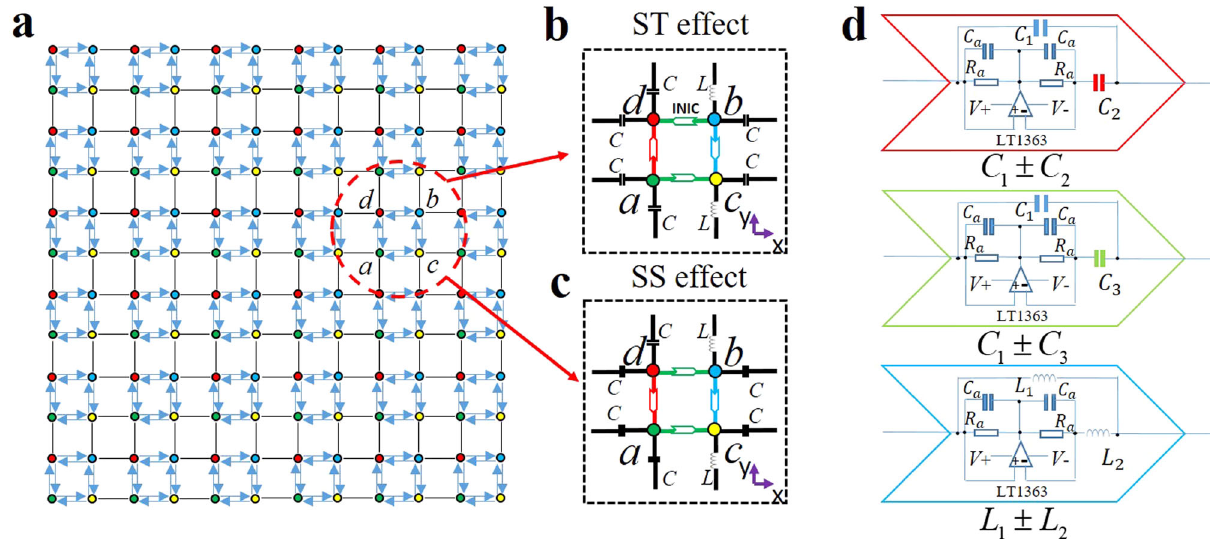
Fig. 1 The circuit design for the hybrid second-order skin-topological (ST) and skin-skin (SS) effects. a Designed 2D electric circuit network with different values of intra-cell and inter-cell couplings. Each unit cell contains four sublattices ( a , b , c , d ). The blue lines with arrows represent INICs which can tune nonreciprocity in the circuit and the black lines denote inter-cell capacitive and inductive couplings. b , c Display the circuit unit for the realization of hybrid second-order ST effect and SS effect with C = 2.2 nF and L = 1.5 uH, respectively. Different colors of INIC indicate different values of non-Hermitian coupling. d Detail structures of different INICs. The components in the INIC(red): C 1 = 1nF, C 2 = 820 pF; INIC(green): C 1 = 1 nF, C 3 = 390 pF; INIC(blue):